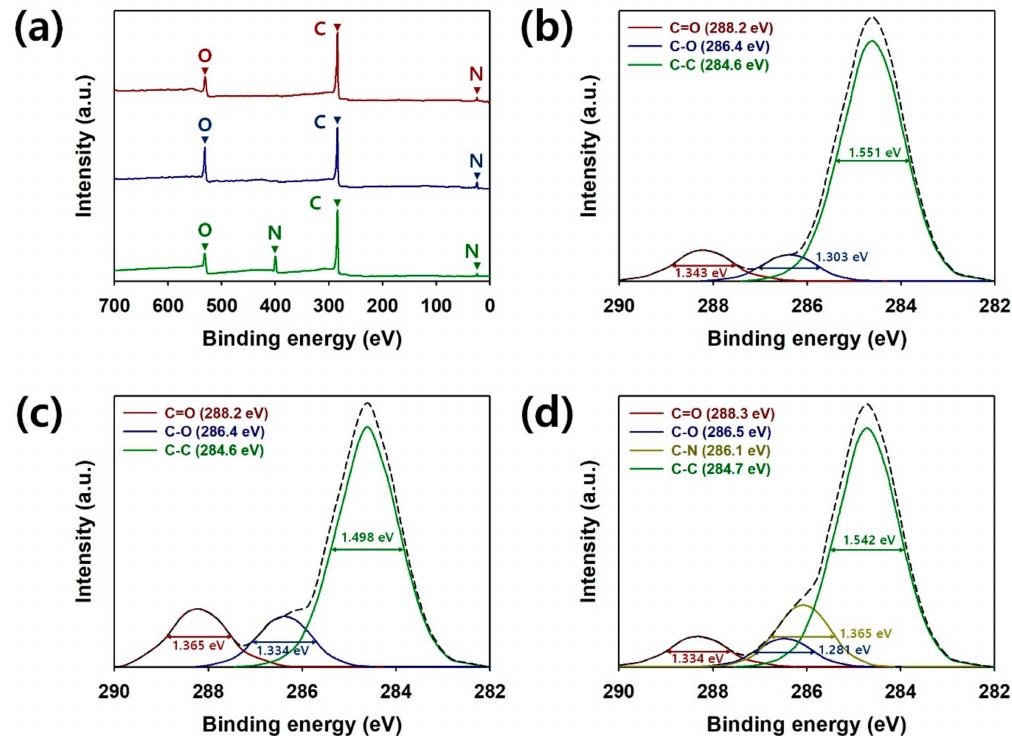
Figure 4. ( a ) The fully scanned X-ray photoelectron spectroscopy (XPS) spectra of pristine graphene (red), O 2 -G (blue) and N 2 -G (green). XPS core spectra in C(1s) region of ( b ) pristine G, ( c ) O 2 -G and ( d ) N 2